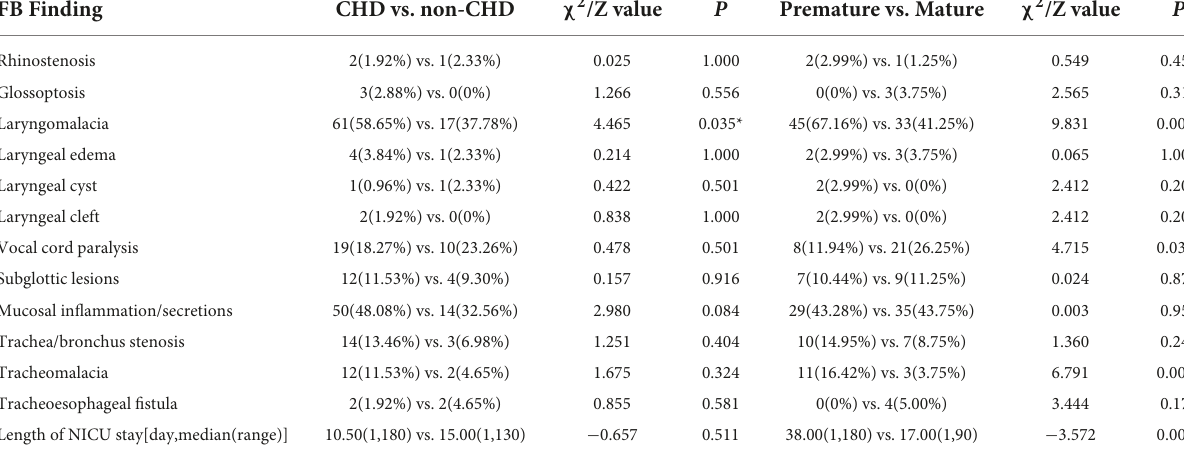
TABLE 4 The correlations between CHD and non–CHD, premature and